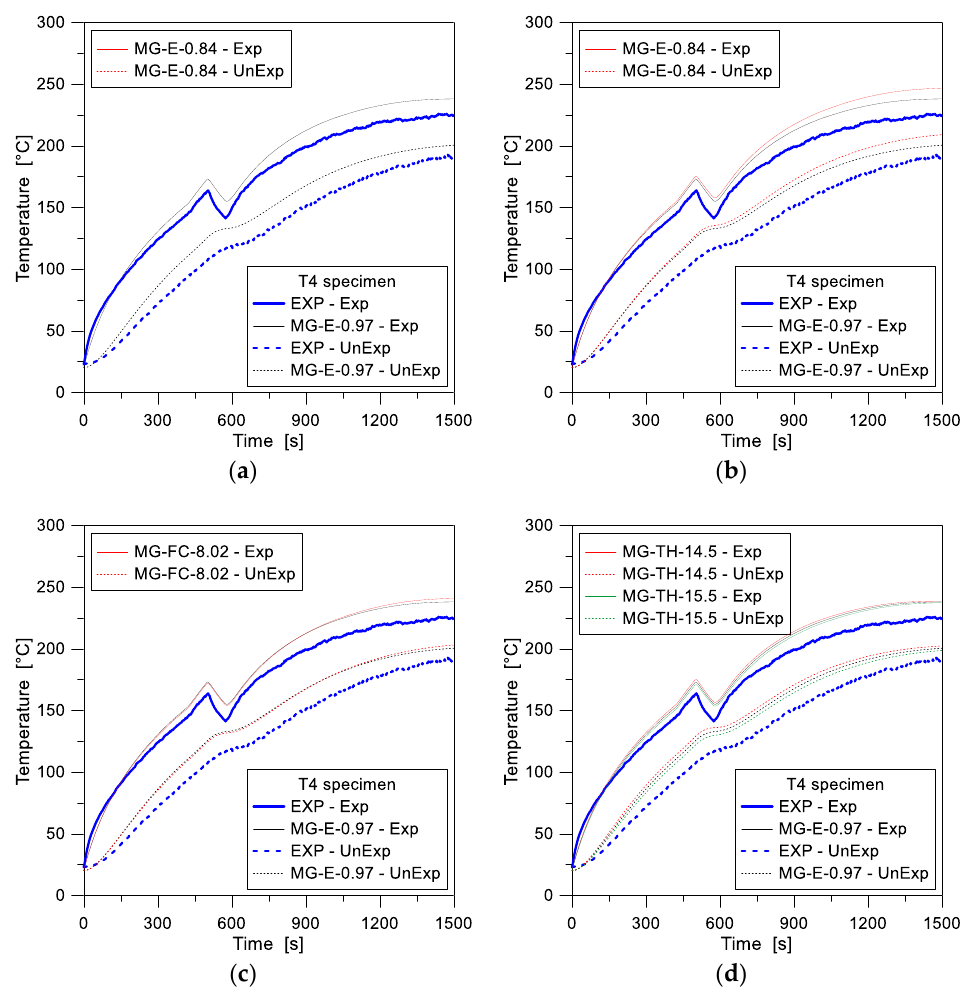
Figure 7. Temperature history comparisons for the MG specimen T4, as obtained from the FE parametric analyses (ABAQUS, 1D) and the past experimental test. FE results from ( a ) the reference 1D model and ( b – d ) the sensitivity study.